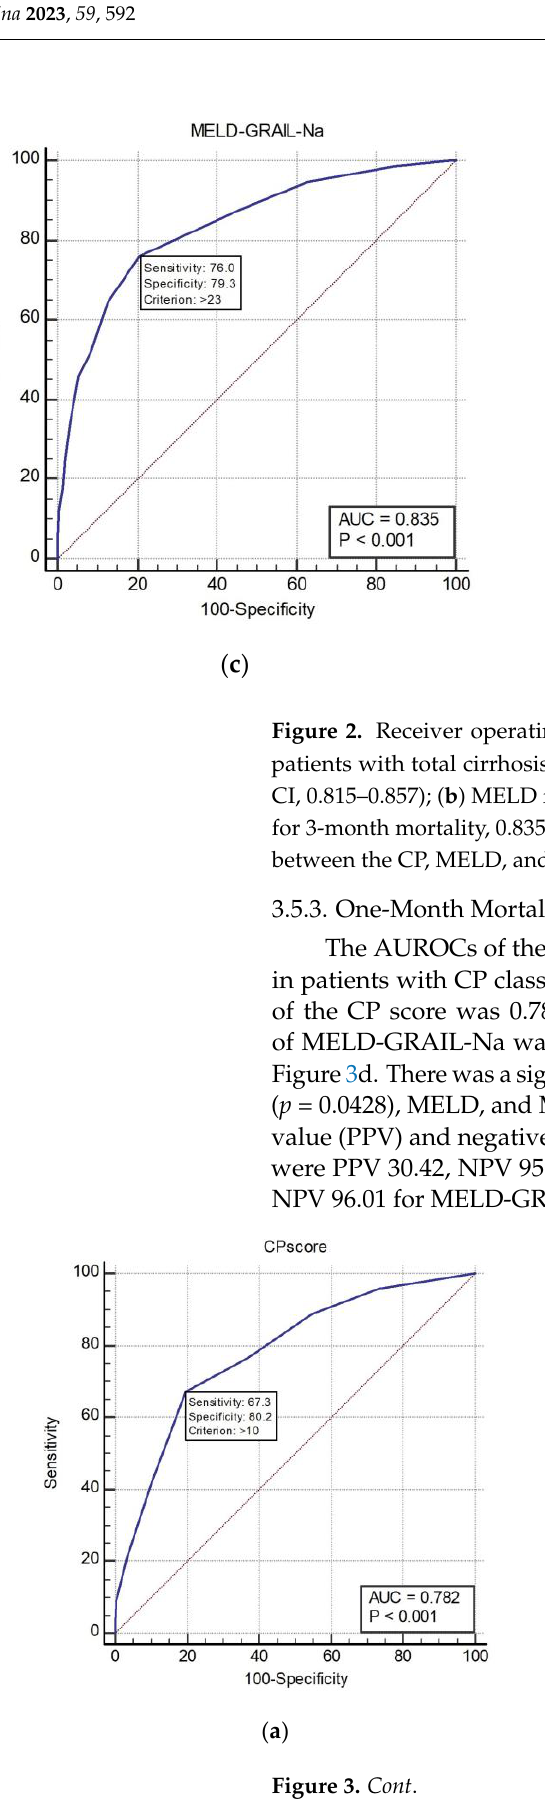
( d ) Figure 3. Receiver operating characteristic curves (ROC) and area under the ROC (AUROC) of pa- tients with CP classes B and C for 1 - month mortality. ( a ) CP score for 1 - month mortality, 0.782 (95% CI, 0.753–0.809), ( b ) MELD for 1 - month mortality, 0.809 (95% CI, 0.781–0.834); ( c ) MELD - GRAIL - Na for 1 - month mortality, 0.825 (95% CI, 0.798–0.850); ( d ) comparison of AUROC for 1 - month mortality between the CP, MELD, and MELD - GRAIL - Na scores. 3.5.4. Three - Month Mortality Prediction in Patients with CP Classes B and C The AUROCs of the CP, MELD, and MELD - GRAIL - Na scores for 3 - month mortality are shown in Figure 4a–c, respectively. The AUROCs of the CP, MELD, and MELD - GRAIL - Na scores were 0.775 ( p < 0.0001), 0.769 ( p < 0.0001), and 0.786 ( p < 0.0001), respectively. A comparison of the AUROCs is shown in Figure 4d. Regarding the 3 - month mortality prediction in patients with CP classes B and C, there were significant differences between the MELD and MELD - GRAIL - Na scores ( p = 0.0225), but no signifi- cant difference was found between the CP score and MELD - GRAIL - Na. Bayesian posi- tive predictive value (PPV) and negative predictive value (NPV) of model/scores in pre- dicting mortality were PPV 39.63, NPV 91.32 for CP score, PPV 35.29, NPV 92.2 for MELD and PPV 33.54, NPV 94.16 for MELD - GRAIL - Na. MELD - GRAIL - Na was high in NPV, but low for PPV.